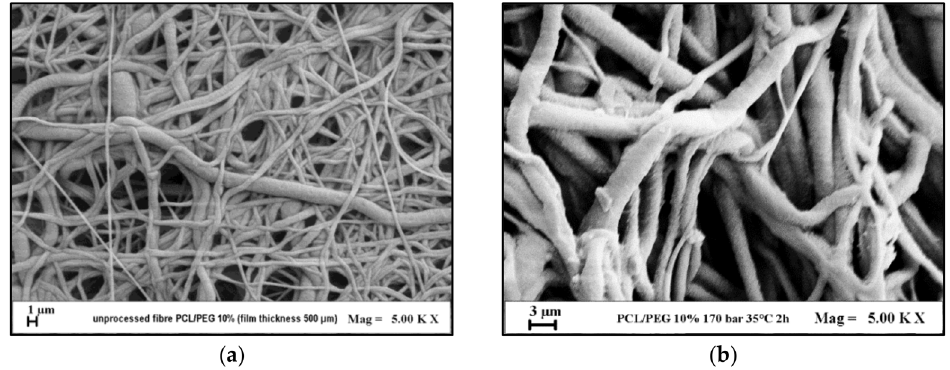
Figure 4. FESEM images of the electrospun films of PCL + PEG 10% with a thickness of 500 µ m: ( a ) before the contact with scCO 2 and ( b ) after the 2 h of contact.